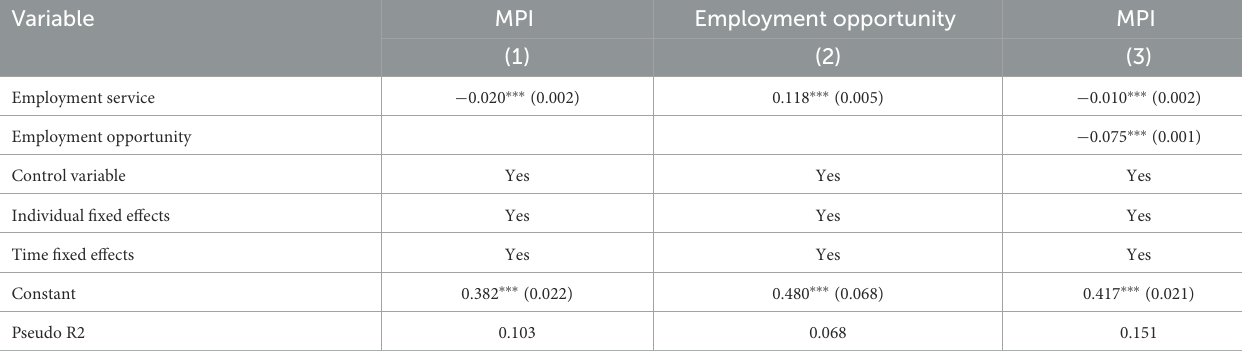
TABLE 10 Results of the mediation effect test of employment opportunities. Variable